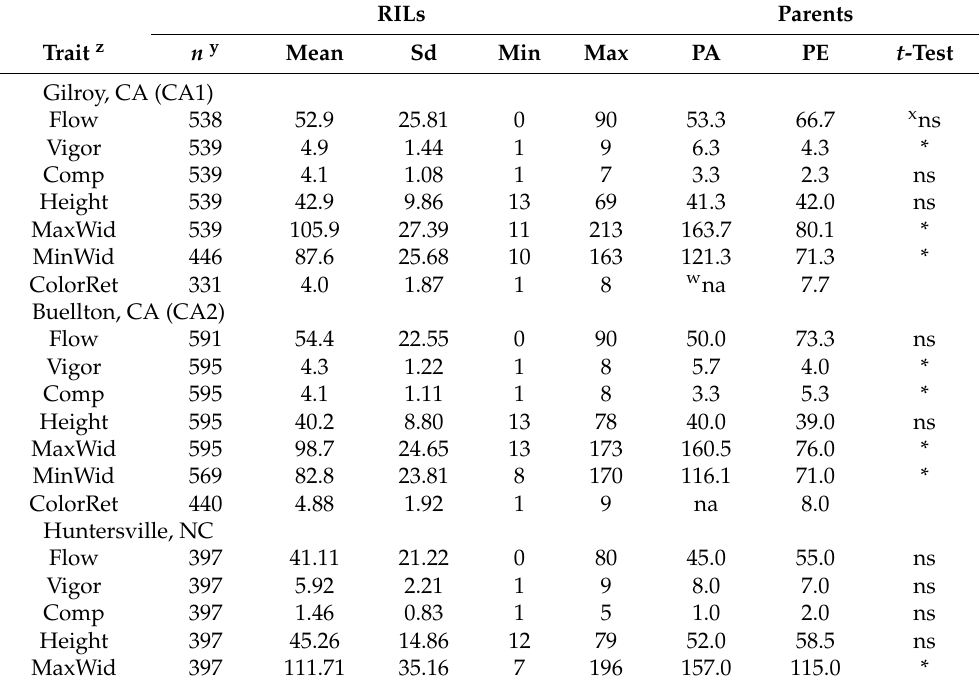
Table 2. Descriptive statistics at four locations for field performance traits analyzed in a P. axillaris × P. exserta F 7 recombinant inbred line